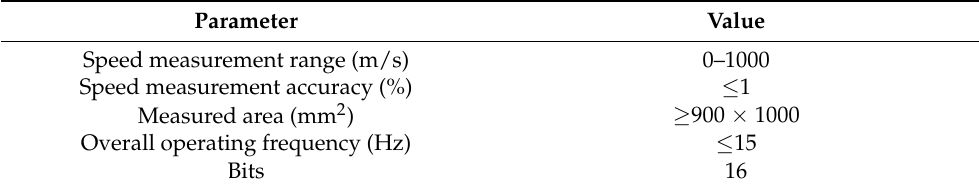
Table 1. Technical indices of the particle image velocimetry (PIV) test